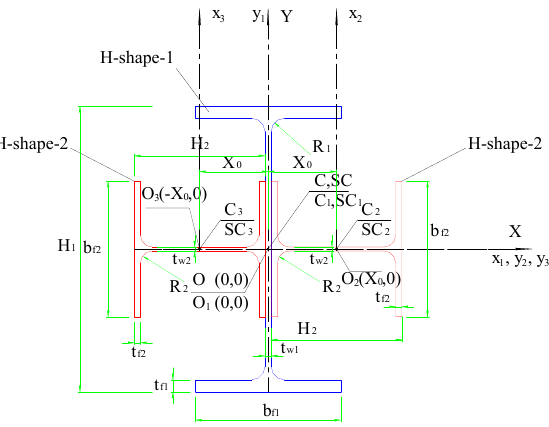
Figure 2. Geometric coordinates and dimensions of the FCHC.